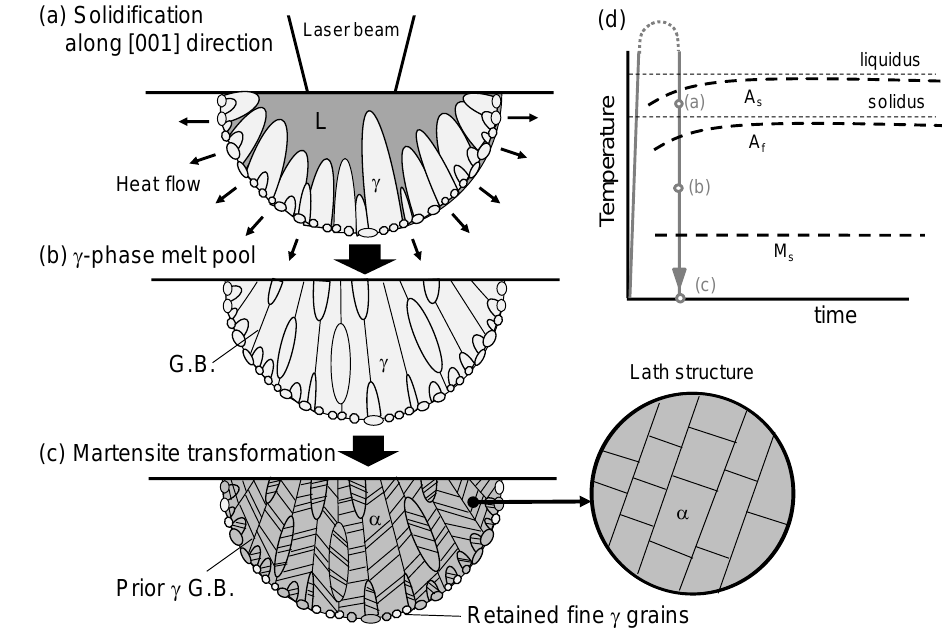
Figure 8. Schematics showing ( a – c ) the formation process of microstructure in the maraging steel during the selective laser melting process, together with ( d ) a schematic thermal history of the sample by local laser heating.